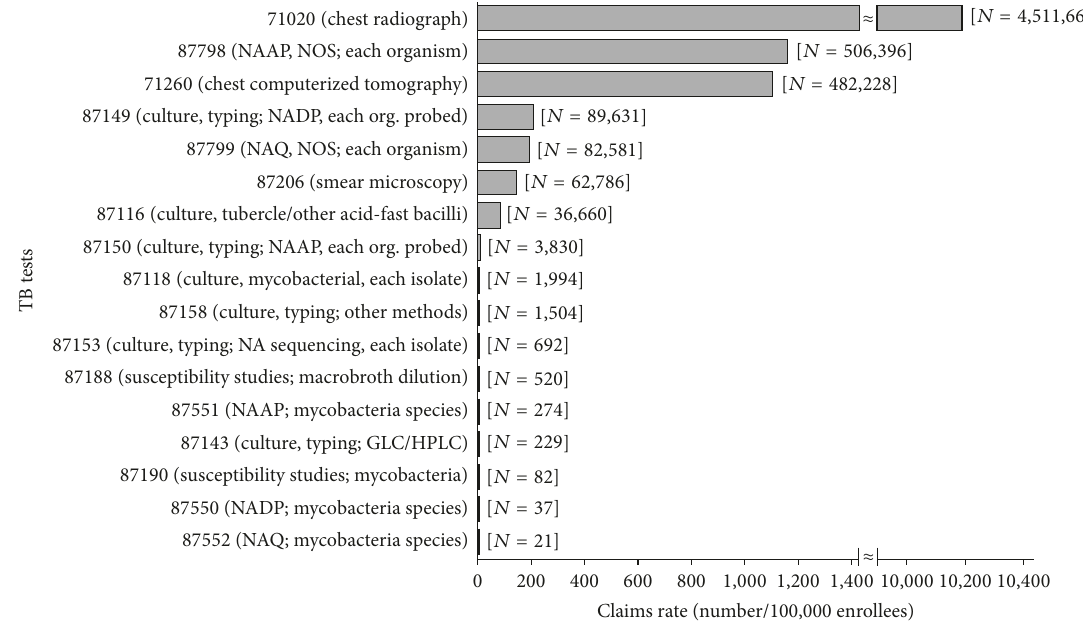
Figure 2: Estimated claims rates (number/100,000 enrollees) for the nonspecific TB tests. TB, tuberculosis; NAAP, nucleic acid amplification probe; NADP, nucleic acid direct probe; NAQ, nucleic acid quantification; NA, nucleic acid; NOS, not otherwise specified; GLC, gas liquid chromatography; HPLC, high pressure liquid